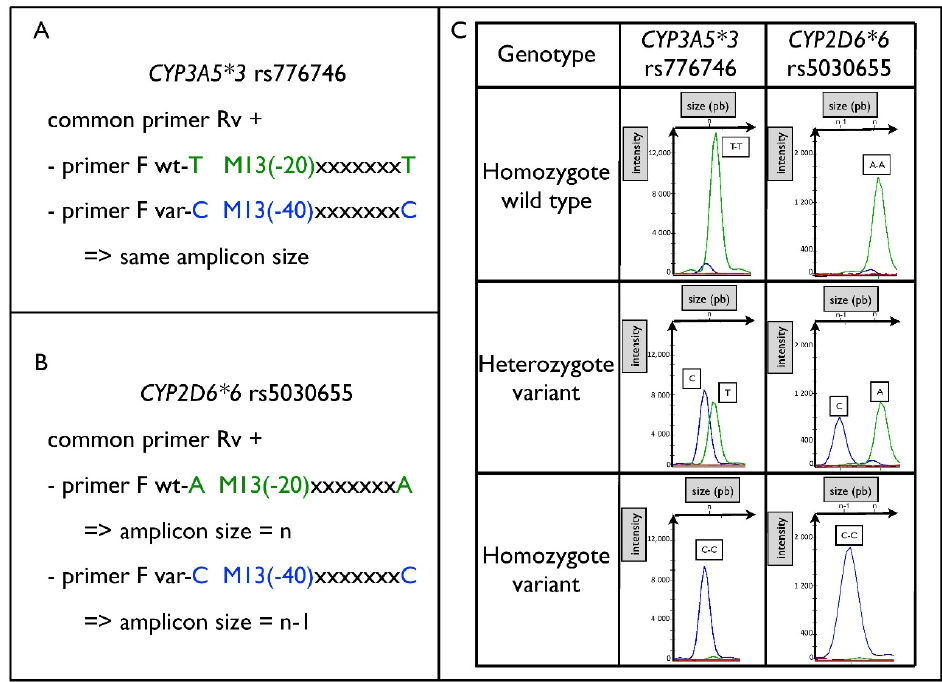
Figure 2. Resolution of a bi-allelic polymorphisms. Primer design for CYP3A5 rs776746 ( A ). Primer design for CYP2D6 rs5030655 ( B ). Representative electropherogram results of the migration of fragments according to genotype ( C ). CYP3A5 rs776746 illustrates results of bi-allelic discrimination for a single-nucleotide polymorphism. CYP2D6 rs5030655 illustrates results for a polymorphism based on the deletion of 1 nucleotide. The green peak corresponds to the fluorescence of the HEX probe (WT) and the blue peak corresponds to the fluorescence of the FAM probe (Variant).